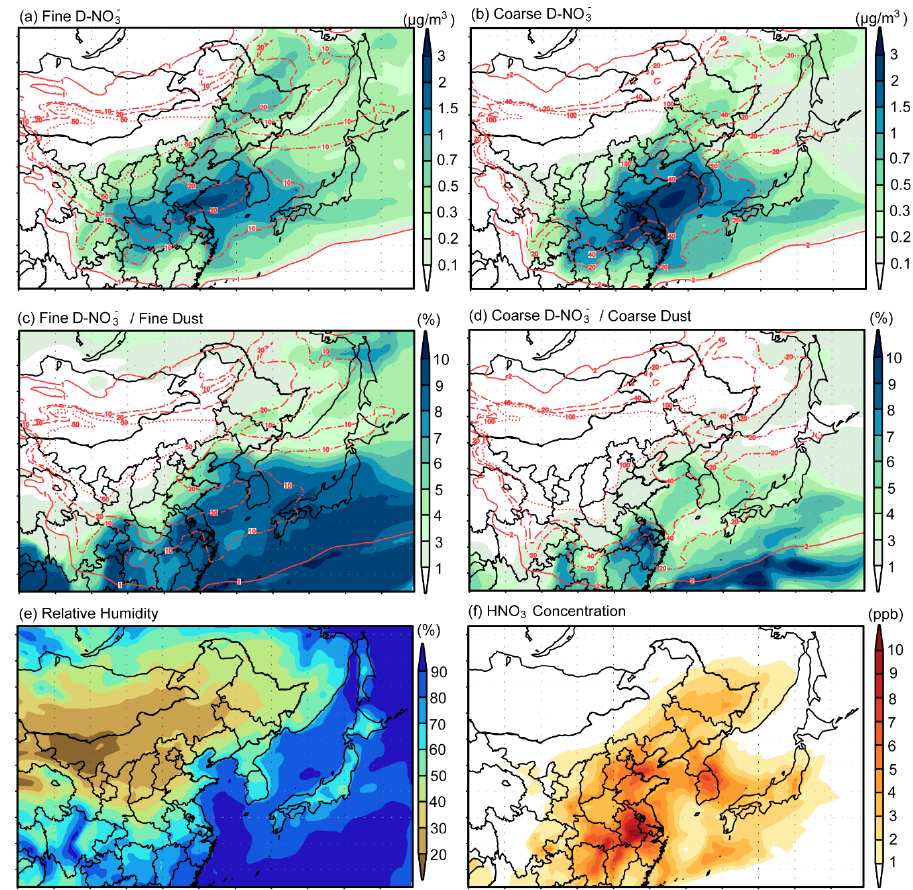
Figure 9. Horizontal distribution of average fine- ( a , c ) and coarse-mode ( b , d ) D-NO 3− concentrations and the ratio of D-NO 3− /dust concentrations by shades and dust concentrations by lines, as well as the RH and HNO 3 concentrations during 3–11 May